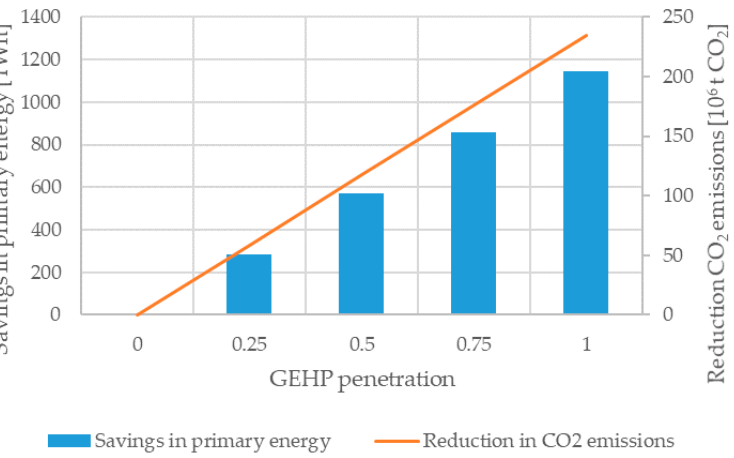
Figure 1. Savings in primary energy and reduction in CO 2 emissions per year considering different GEHP penetrations in satisfying the European space heating demand.